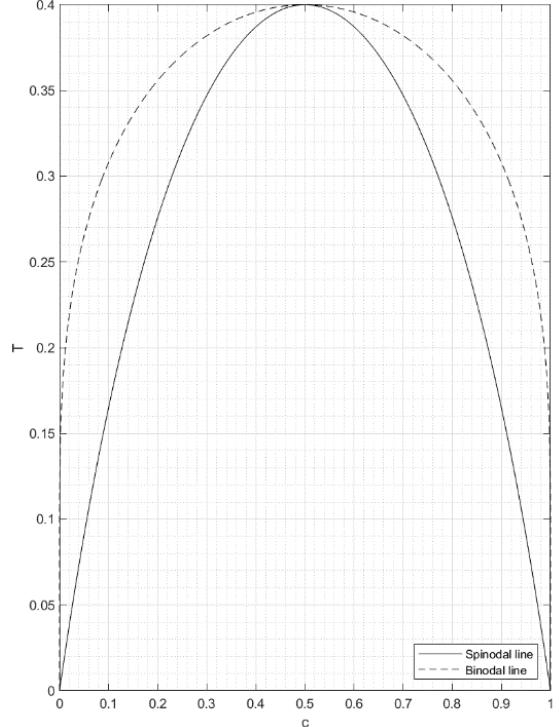
Figure 1. Binary phase diagram for N 1 = N 2 = 1 and Ψ =